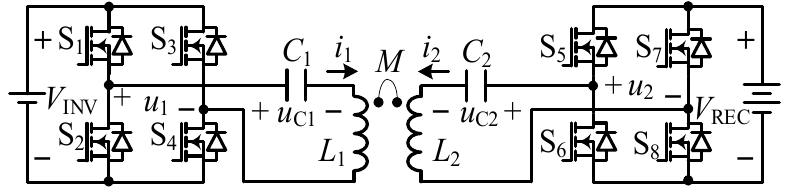
Figure 1. Topology of a series–series compensated WPT system for EV charging.